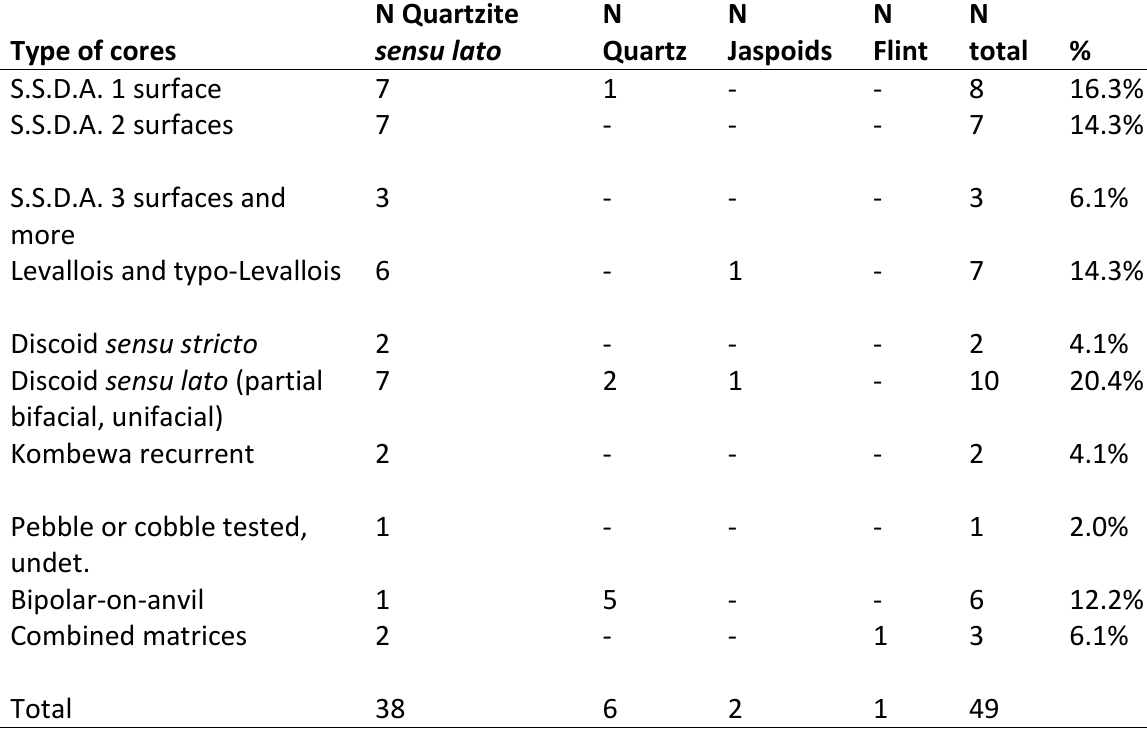
Table 7. Main types of cores identified at